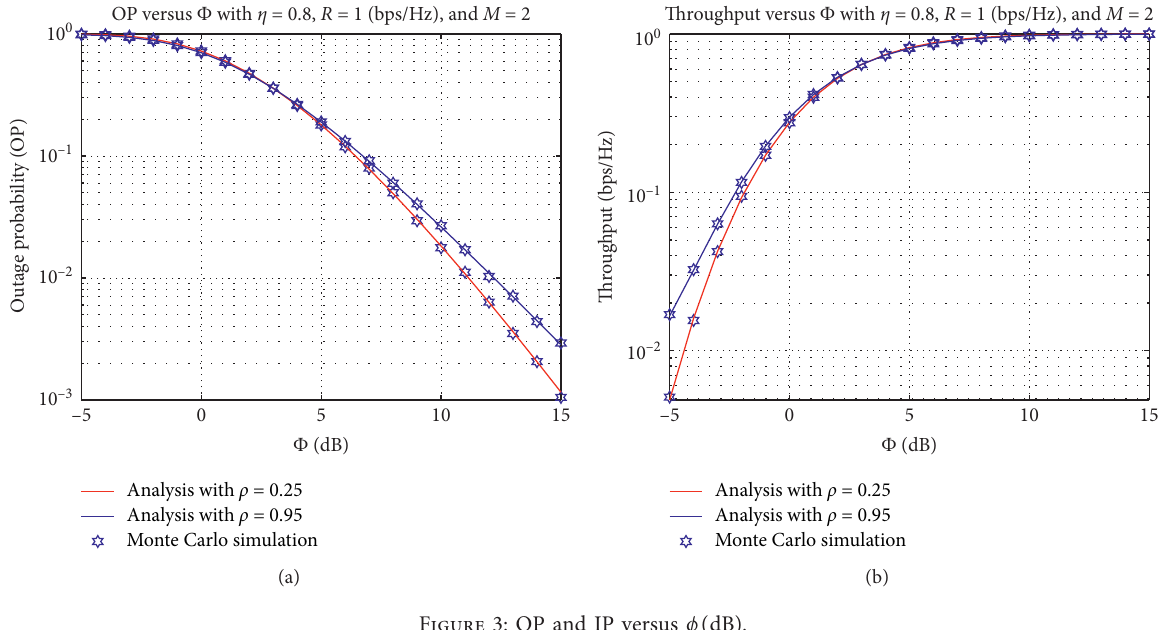
Figure 3: OP and IP versus ϕ ( dB ) .